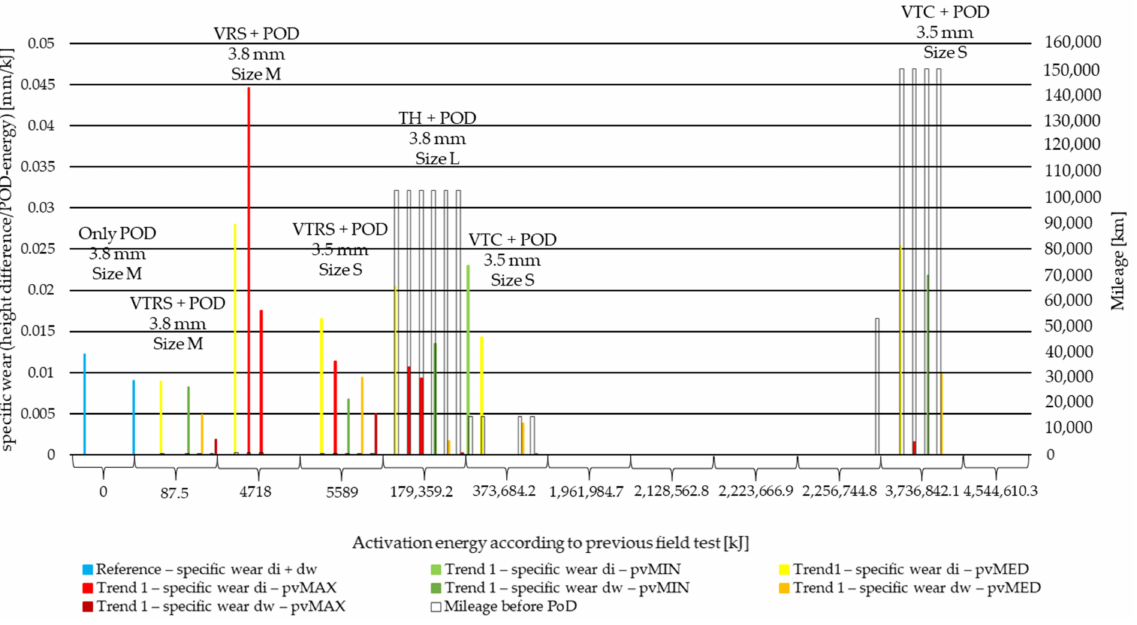
Figure 11. PoD specific wear values of cut material samples from inner and working diameter after minimum, medium and maximum pv level pin-on-disc tests with previous field-test (Table 2) mileage along Joule scale—Trend 1: clutch killer load cases: VTRS, VRS, TH,